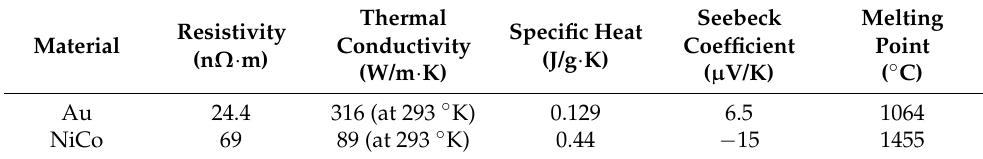
Figure 2. Schematic drawings of the cross-sections of the two types of probes: ( a ) NiCo probe; ( b ) Au–NiCo probe. Table 1. Properties of materials used in analyses of the current-carrying